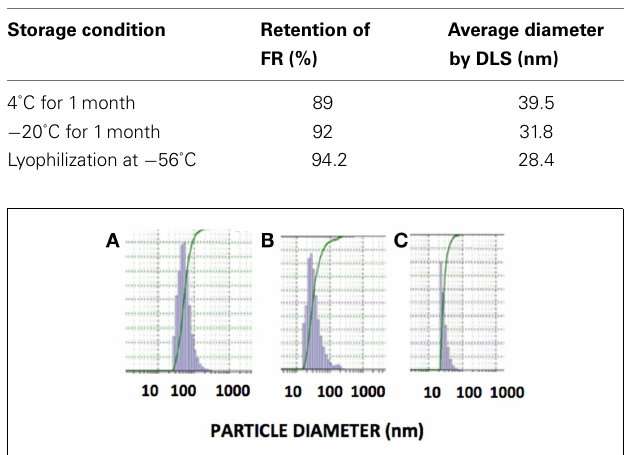
Table 1 | Comparative IC 50 doses of free and rHDL encapsulated FR on Neuroblastoma cells and retinal pigment epithelial cells.